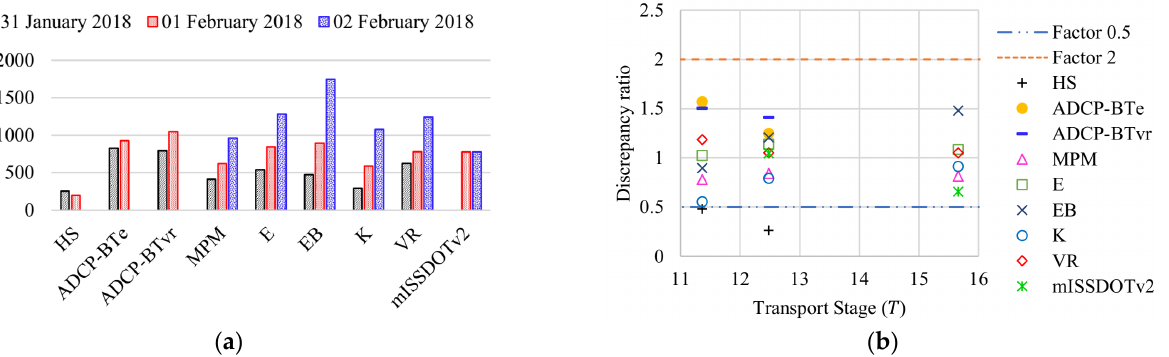
Figure 16. ( a ) Total bedload estimates at cross-section P1; ( b ) discrepancy ratios of total bedload estimates.